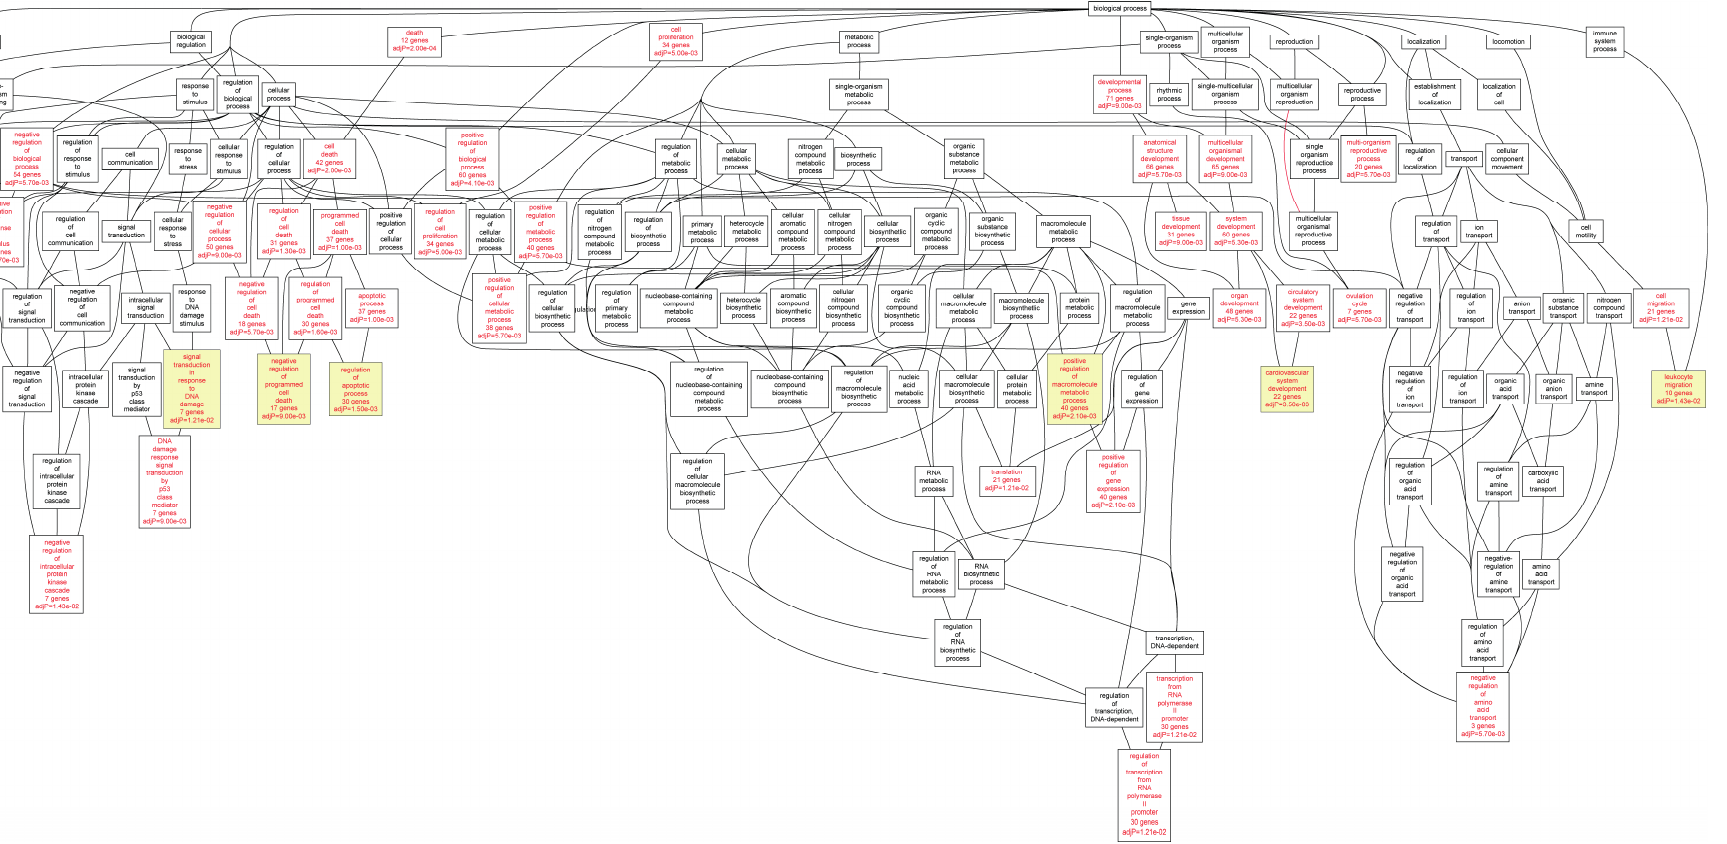
Figure 8. Biological categories of the target genes of transcription factors RUNX1, ELF1, ETS2 and STAT5 that were also differentially expressed in the AAA neck region. The gene list was obtained from a previously published study on RNA samples isolated from the neck regions of AAAs [40]. A DAG of the GO categories of the set of 282 genes was generated by the web application WebGestalt [32]. Categories shown in red were significant (adjusted p < 0.001). The categories on the 6th level of hierarchy are discussed in the text and are shown here with a yellow background. See Tables 12 and S11 for additional